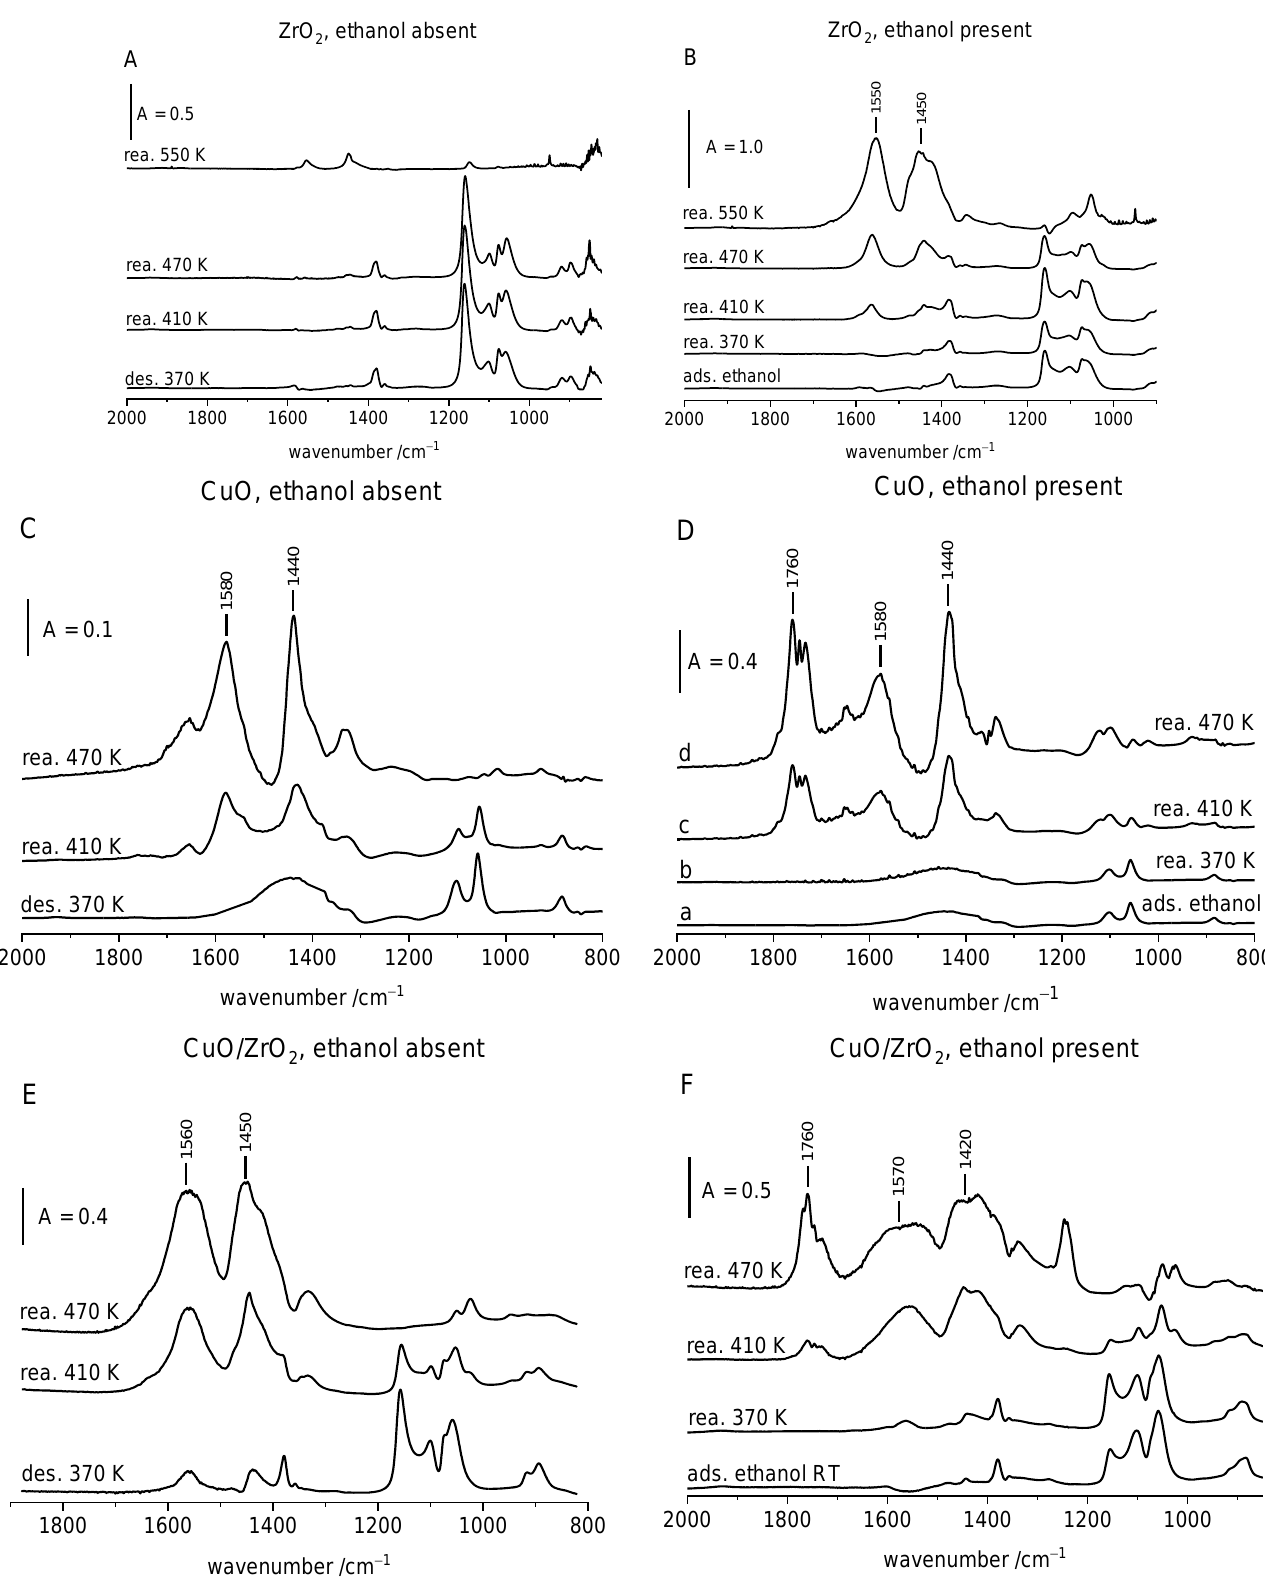
Figure 6. The spectra recorded upon the adsorption of ethanol on ZrO 2 , CuO and CuO/ZrO 2 at room temperature and subsequent evacuation at 370 K (gaseous ethanol absent) ( A , C , E ) or upon the adsorption without evacuation (gaseous ethanol 15 Tr. present) ( B , D , F ). Spectra were recorded upon heating to 370, 410, 470 and (for ZrO 2 ) 550 K and subsequent cooling to RT. The spectra of gaseous ethanol were subtracted.